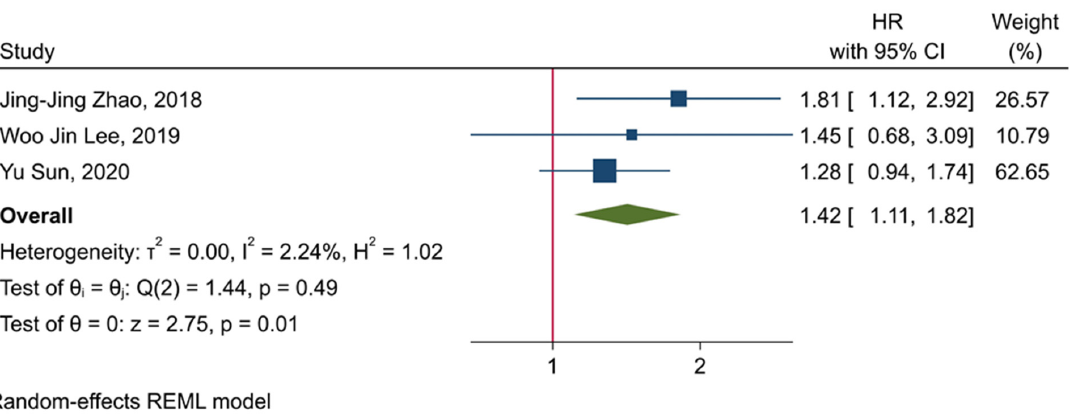
Figure 4. Forest plot for evaluating the prognostic value of TIGIT expression in determining the OS of affected patients.